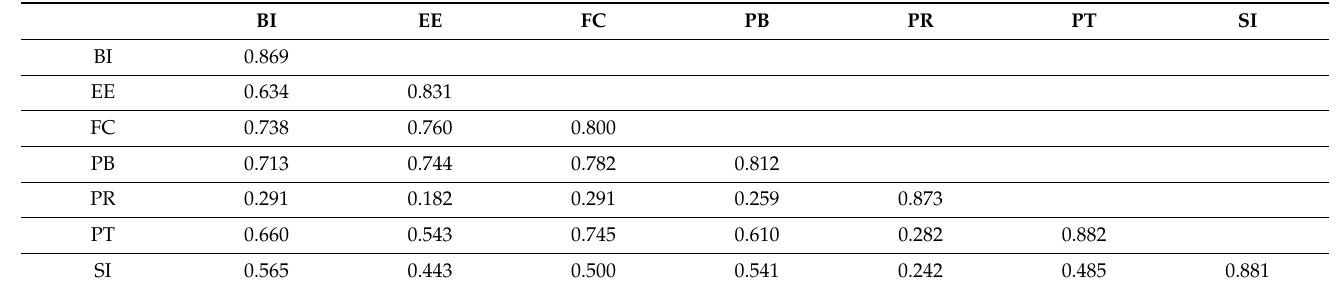
Table 4. Discriminant validity and average variance extracted (AVE) values.